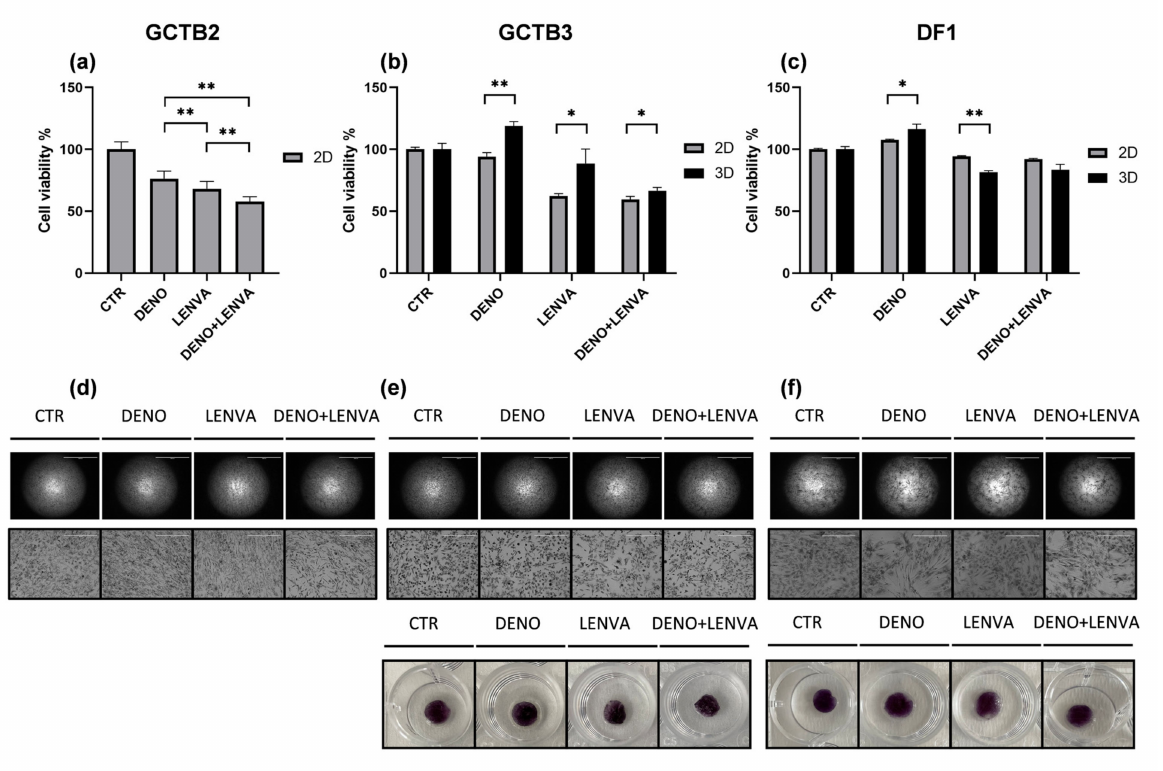
Figure 3. Pharmacological analysis of: ( a ) 2D GCTB2 primary culture, ( b ) 2D and 3D GCTB3 primary culture, ( c ) 2D and 3D DF1 primary culture. Representative images of ( d ) 2D GCTB2, ( e ) 2D and 3D GCTB3 ( f ) 2D and 3D DF1, exposed to the tested drugs, 2 × and 10 × magnification. GCTB and DF primary cultures were exposed to DENO, LENVA, DENO + LENVA. Significant differences among treatments were accepted for p < 0.05 (*) and p < 0.001